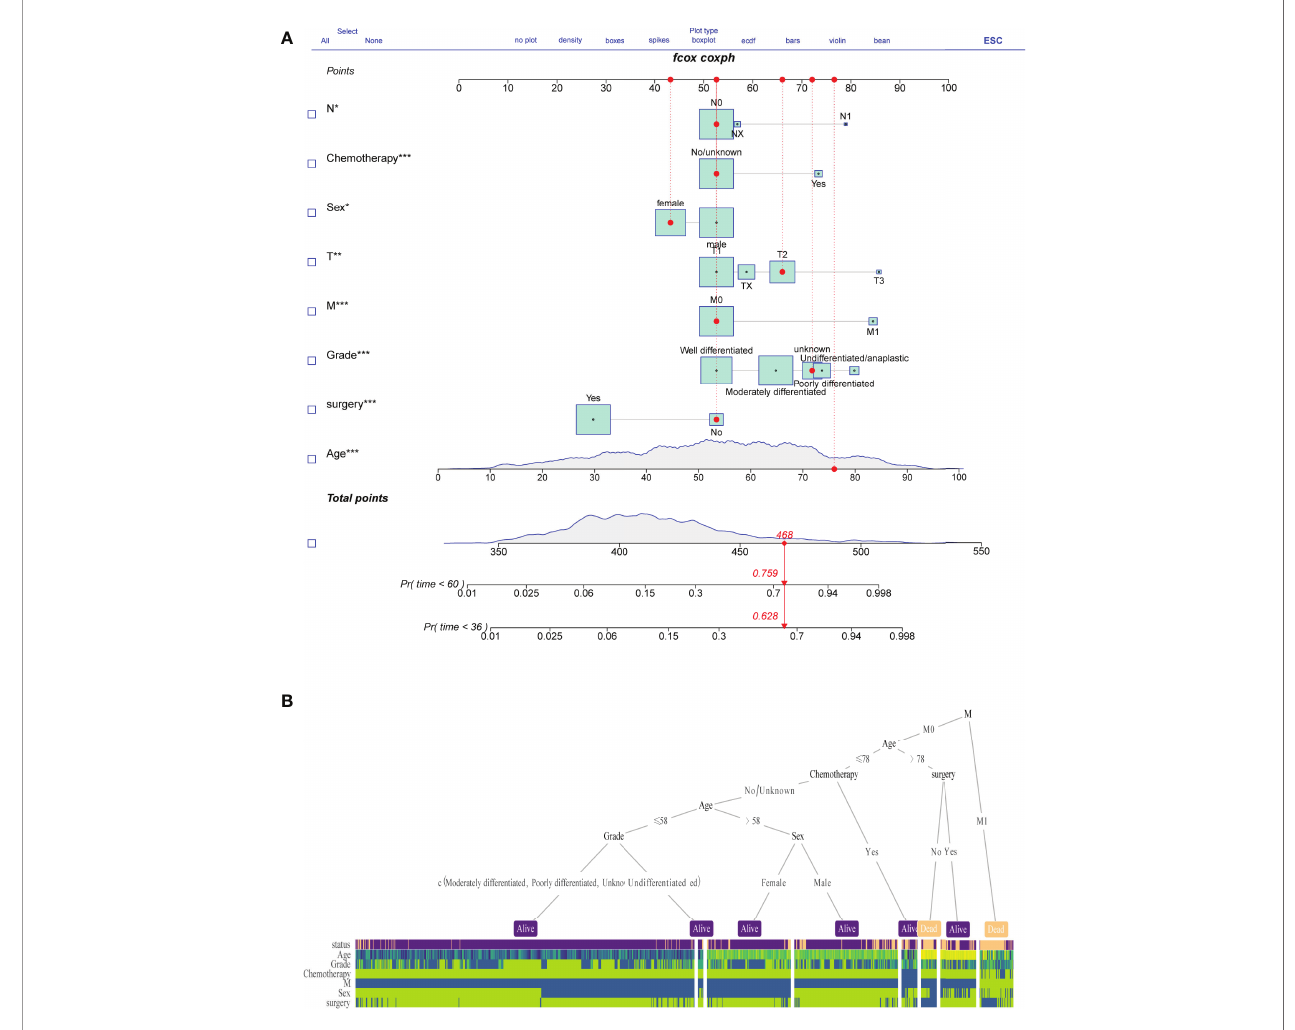
FIGURE 3 | Nomogram model construction. Survival risk nomogram (A) and decision tree (B) for the prediction